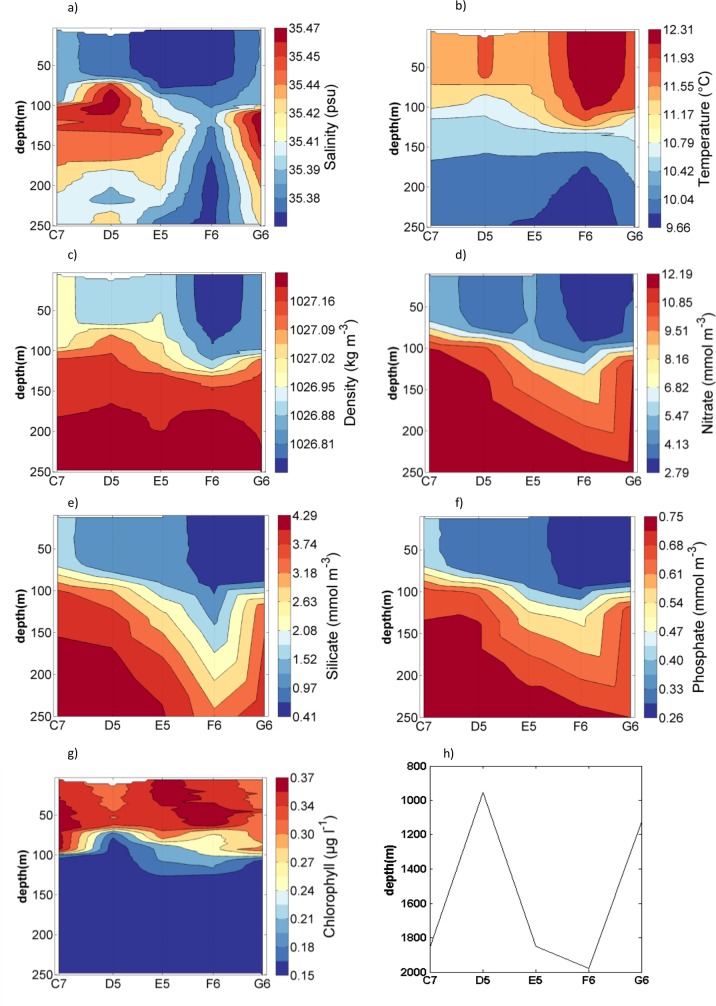
Contour plots for shelf break stations (top 250 m) for a) Salinity, b) Water temperature, c) Density, d) Nitrate, e) Silicate, f) Phosphate, g) Chlorophyll from fluorescence and h) water depth.